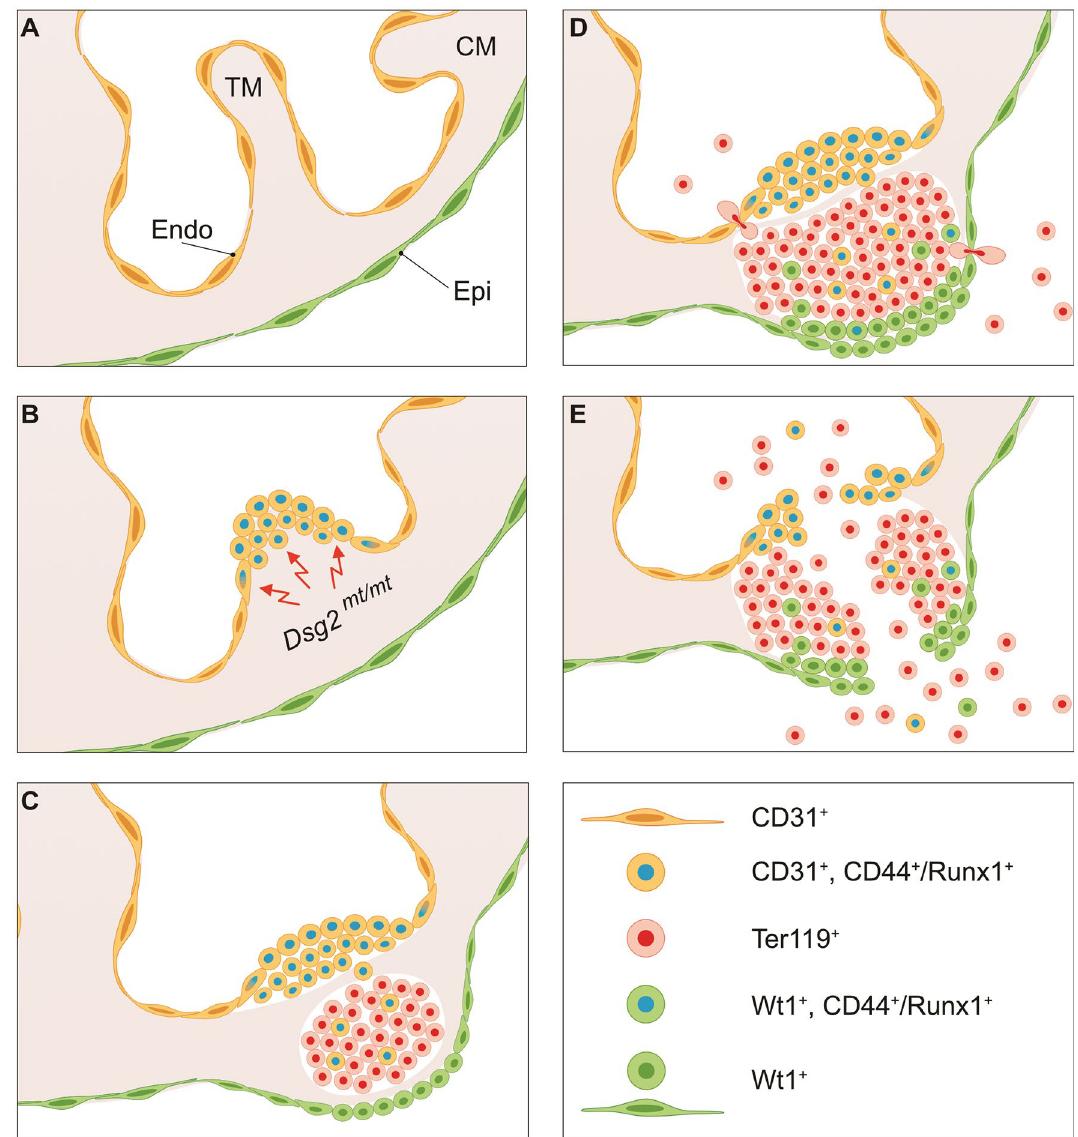
Figure 9. The scheme summarizes findings of altered differentiation in Dsg2 mt/mt embryonic hearts. ( A ) depicts the unperturbed situation in embryonic heart with trabecular and compact myocardium (TM and CM, respectively) that is covered by monolayers of endocardial cells (Endo) facing the heart chamber and epicardial cells (Epi) facing the pericardial cavity. ( B ) In the Dsg2 mt/mt heart loss of cardiomyocyte integrity triggers endocardial CD31 + cells to proliferate and differentiate into CD44 + /Runx1 + hematopoietic cells on the tip of trabecular myocardium generating type A cell clusters. ( C ) CD44 + /Runx1 + cells invade the myocardial wall where they differentiate and proliferate forming clusters of Ter119 + erythroid type B cell clusters. At the same time, epicardial Wt1 + cells obtain a round shape. ( D ) Type A and type B cell clusters proliferate accompanied by increasing numbers of Wt1 + cells, some of which become CD44 + /Runx1 + and some of which invade the cell clusters. At the same time, nucleated erythrocytes leave the type B cell clusters by transmigration through endo- and epicardial cells leading to pericardial hemorrhage prior to rupture occurrence. ( E ) Amplification of cells that are less adhesive than cardiomyocytes and concurrent reduction of the myocardial continuity lead to cardiac wall embryos repair their heart muscle without any remaining damage. This may, at least in part, be due to extrusion of abnormal cell clusters and transmigration of matured erythrocytes from type B lesions either into the heart chambers or the pericardial cavity. Interestingly, mid gestation embryonic mortality has also been reported in mice with null mutation in the desmosomal proteins plakoglobin (Jup) and plakophilin 2 (Pkp2) 13,33 . Similar to the Dsg2 mt/mt embryos, pericardial hemorrhage and reduced trabeculation was observed. Notably, reduced Dsg2 expression was reported in Pkp2-deficient hearts, suggesting they may have similar mechanisms in the dysregulation of cardiogenesis.